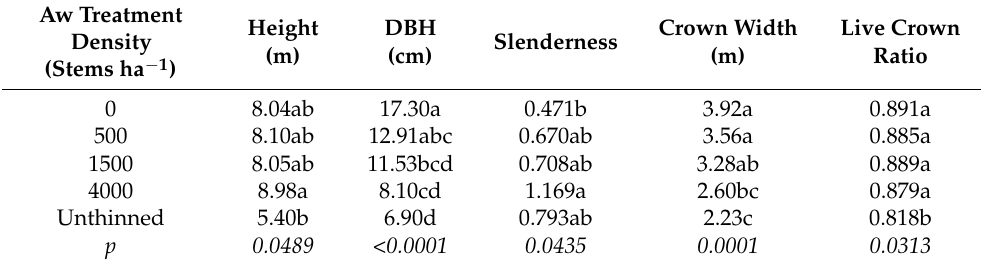
Table 3. Effects of aspen thinning (Aw treatment density) on height, diameter at breast height (DBH), slenderness, crown width, and live crown ratio for the trees sampled in each treatment. Within each column, means followed by different letters were found to differ significantly ( α = 0.05) based on Tukey’s HSD test. ( α = 0.05).